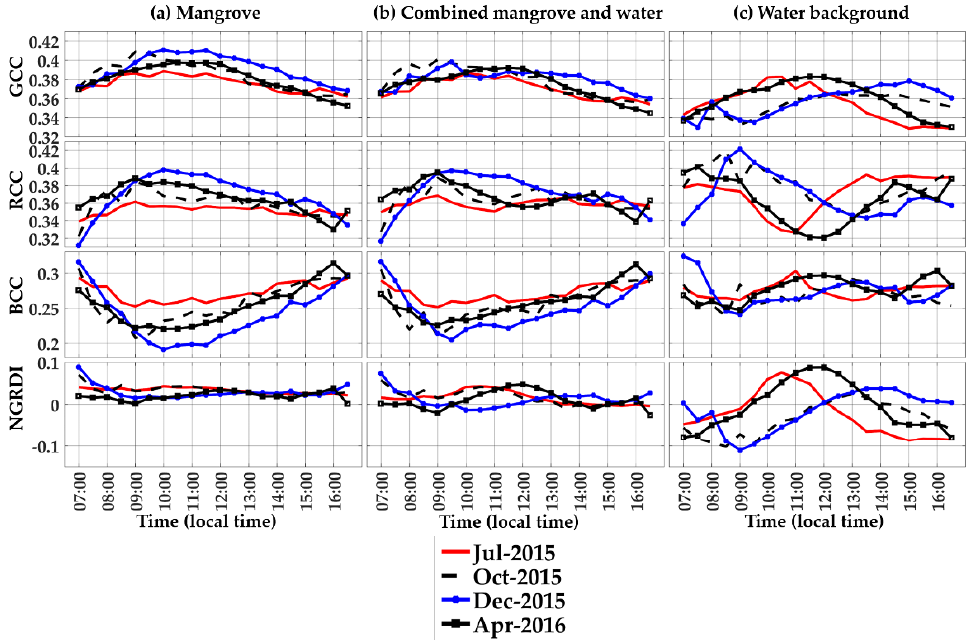
Figure 3. Diurnal variations of the phenocam-2 RGB color indices (GCC, RCC, BCC, and NGRDI) over 4 seasonal periods of the year for ( a ) the mangrove forest (ROI 1), ( b ) combined mangrove-water canopy (ROI 2), and ( c ) water background (ROI 4). The diurnal profiles were measured at 30-min intervals and 3-day averages for each seasonal period (14–16 July 2015; 18–20 October 2015; 29–31 December 2015; 7–9 April 2016). The local time was GMT + 07 h.